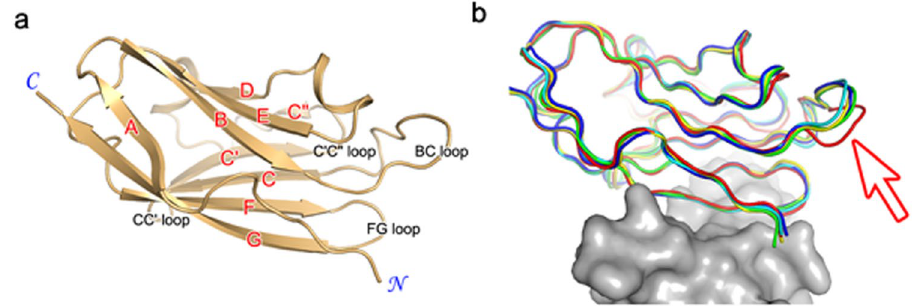
Figure 4. Intrinsic structural rigidity of PD-L1. ( a ) Canonical designation of the strands (red labels) and loops (black labels) within PD-L1. The N- and C-termini are labeled in blue. ( b ) Superposition of the PD-L1 protein extracted from the structures in complex with PD-L1 (blue), atezolizumab (red), durvalumab (cyan), BMS- 963559 (yellow), and avelumab (green). The arrow indicates the conformational change of the BC loop in PD-L1 upon binding to atezolizumab. The bound PD-1 protein is shown as a gray surface model. The orientation of PD-L1 is the same as that in ( a